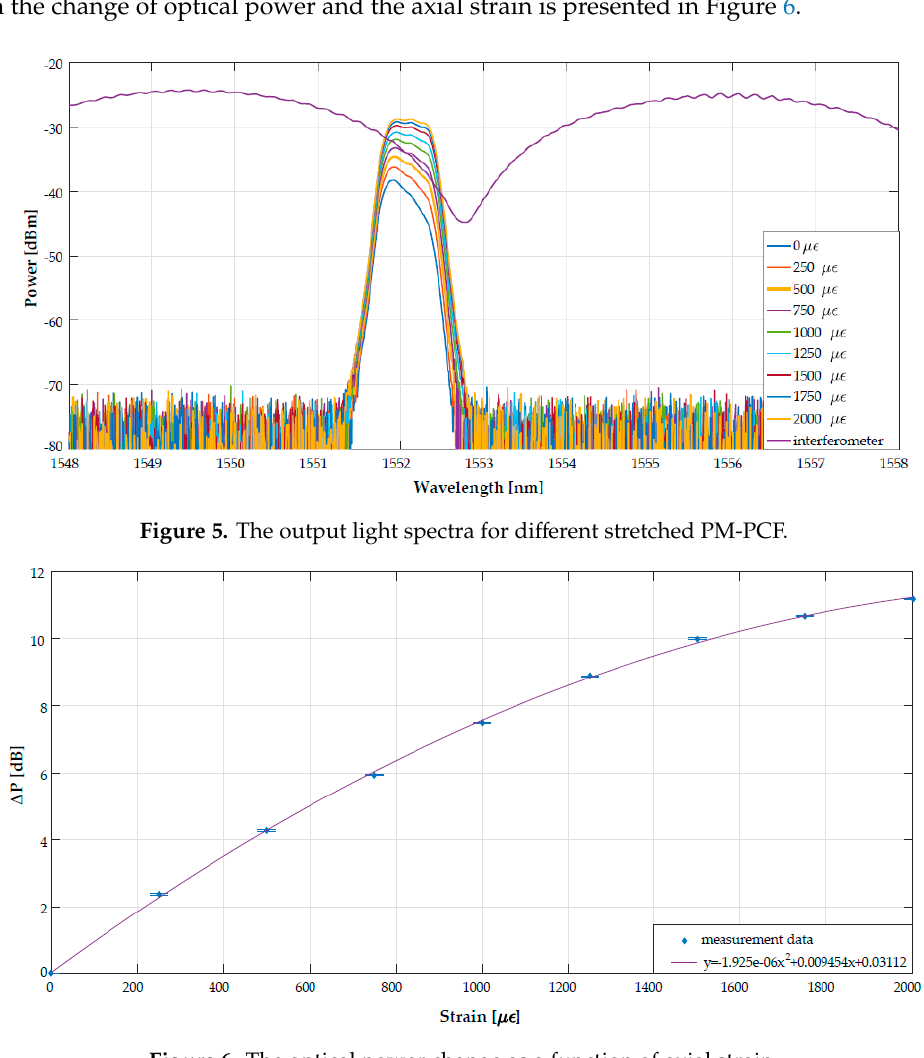
Figure 6. The optical power change as a function of axial strain.